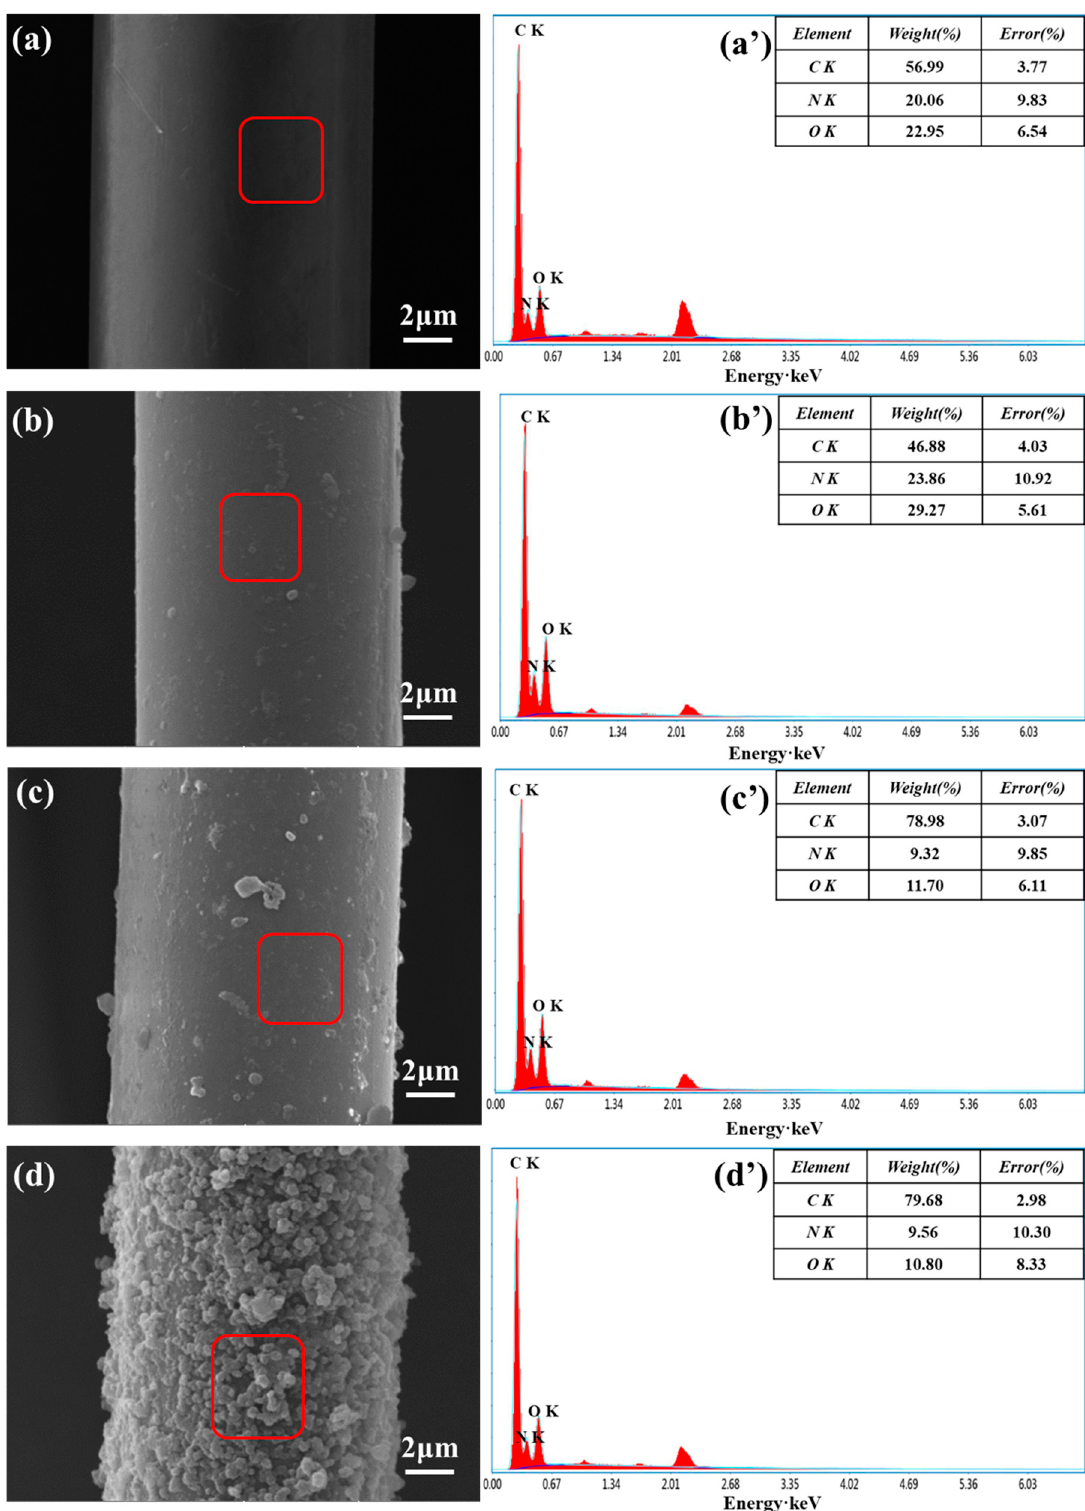
Figure 3. SEM images of ( a ) pristine PPTA fibers, ( b ) plasma-treated PPTA fibers, ( c ) pristine PPTA-PDA fibers and ( d ) plasma-treated PPTA-PDA fibers. Energy spectrum of ( a’ ) pristine PPTA fibers, ( b’ ) plasma-treated PPTA fibers, ( c’ ) pristine PPTA-PDA fibers and ( d’ ) plasma-treated PPTA-PDA fibers.